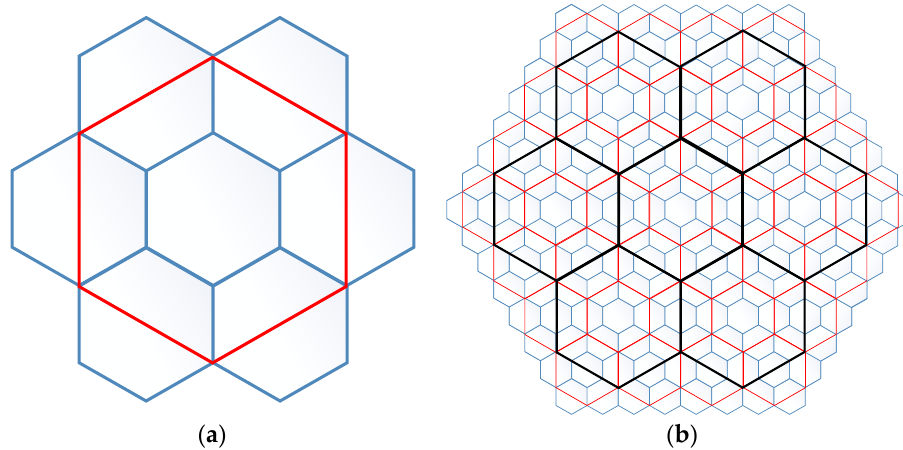
Figure 1. Planar hexagonal grid structure. ( a ) Ratio of the area of two adjacent layers, which is 4. The ratio of the side lengths of the two layers is 2; ( b ) unit structure between different layers, and all the unit directions are the same.